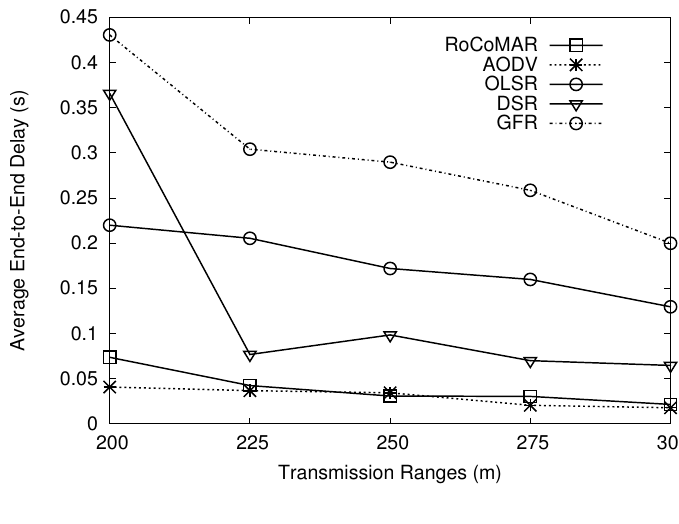
Figure 14. Effects of of transmission range on average end-to-end delay.